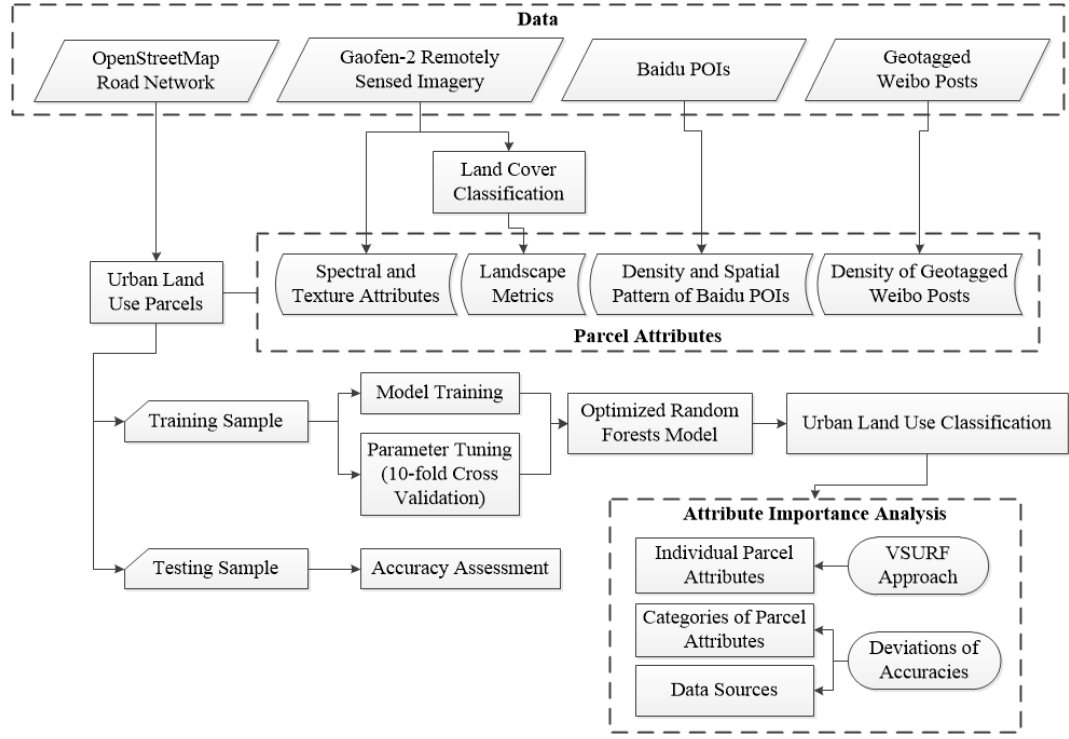
Figure 1. Diagram of the methodological framework of urban land use classification.